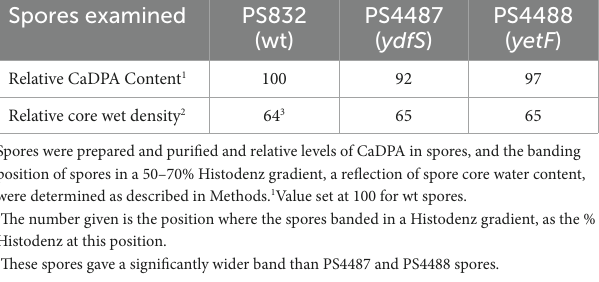
TABLE 3 Levels of CaDPA and core water content in spores +/ − YetF or YdfS. Spores